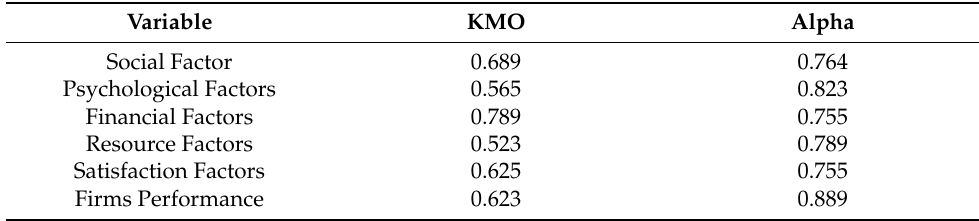
Table 1. Kaiser–Mayer–Olkin and Cronbach’s alpha